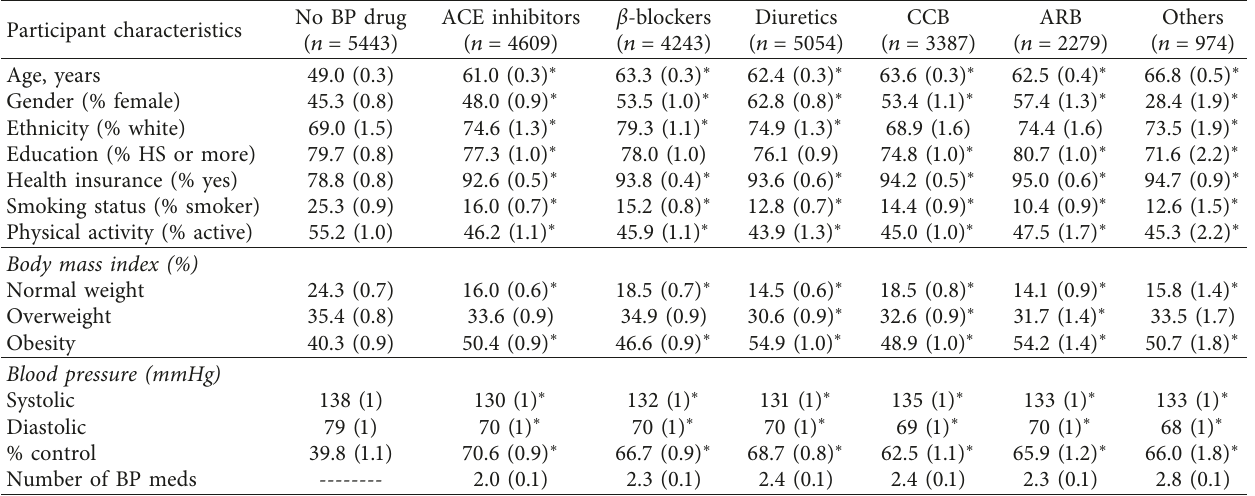
Table 1: Descriptive characteristics of US adults with hypertension by antihypertensive medication type (NHANES 1999–2014). Participant